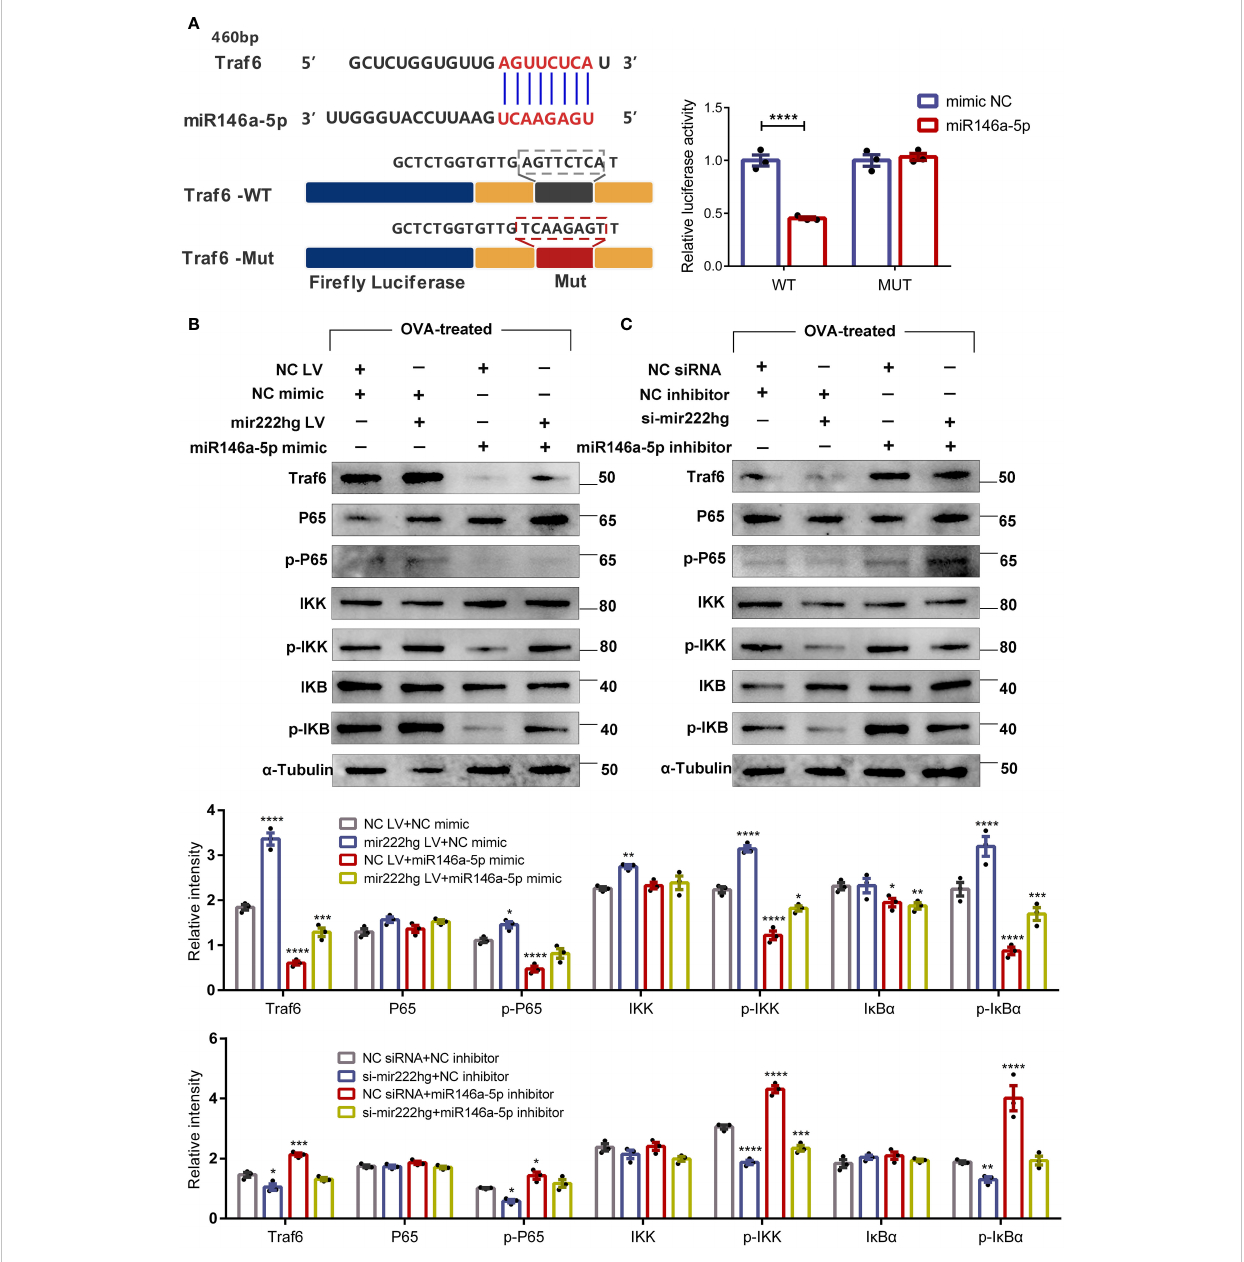
FIGURE 8 Mir222hg/miR146a-5p/Traf6 axis modulated macrophage polarization via the IKK/I k B/NF- к B signaling pathway (A) A schematic showing the putative miR146a-5p binding sites with the 3 ’ -UTR of Traf6. The sequences of Traf6-WT and Traf6-Mut are as listed. Luciferase reporter gene assays were performed to validate the correlation between Traf6 and miR146a-5p in 293T cells. (B, C) RAW264.7 cells were transfected with NC siRNA + NC inhibitor, si-mir222hg + NC inhibitor, NC siRNA + miR146a-5p inhibitor, si-mir222hg + miR146a-5p inhibitor, NC LV + NC mimic, mir222hg LV + NC mimic, NC LV + miR146a-5p mimic, or mir222hg LV + miR146a-5p mimic, respectively. The transfected RAW264.7 cells were then treated with 500 m g/ml OVA for 48 h. The relative protein expression levels of Traf6, P65, p-P65, I k B a , p-I k B a , IKK, and p-IKK were determined by western blotting in transfected cells after normalization to a -Tubulin. Each point represents data from one individual sample. Data are shown as the mean ± SEMs (n= 3 per group). Data are merged from three independent experiments. Blots are representative of three independent experiments. Statistical signi fi cance was assessed by unpaired t-test for experiments comparing two groups, whereas two-way ANOVA followed by Sidak ’ s multiple comparisons test was used for comparisons between more than two groups. * p< 0.05, ** p< 0.01, *** p< 0.001, **** p<